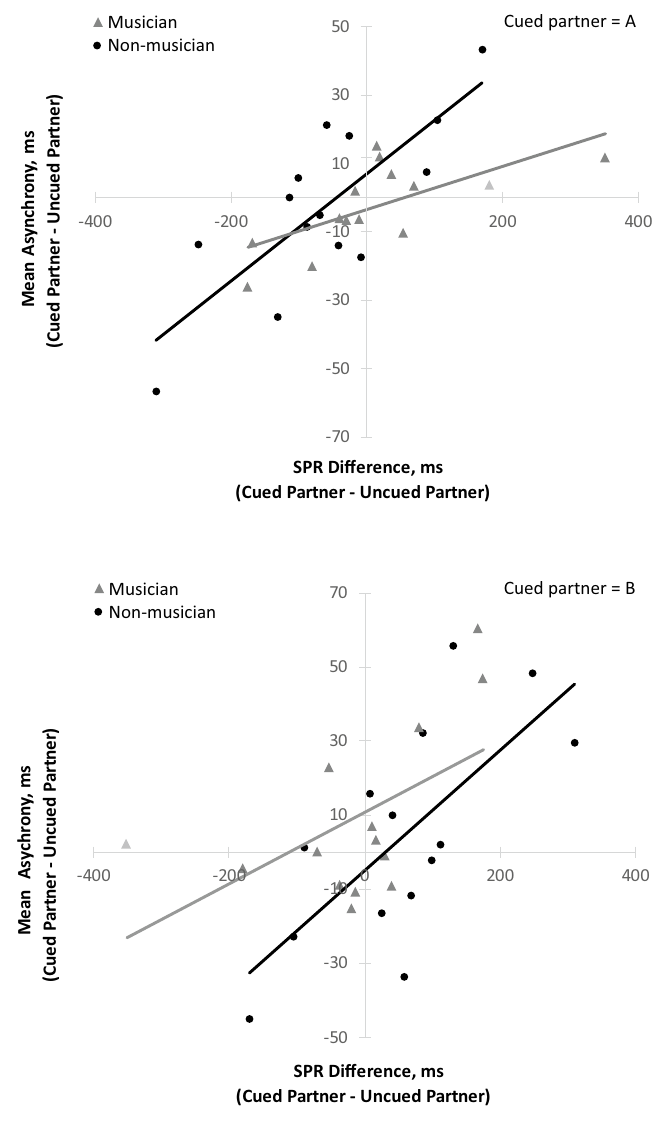
Figure 3. Duet synchronization task: mean asynchrony (cued partner–uncued partner, ms) plotted by partners’ Solo SPR difference (Cued partner–uncued partner, ms). Each marker represents one pair. Top: Condition A (cued rate = PartnerA), Bottom: Condition B (cued rate =